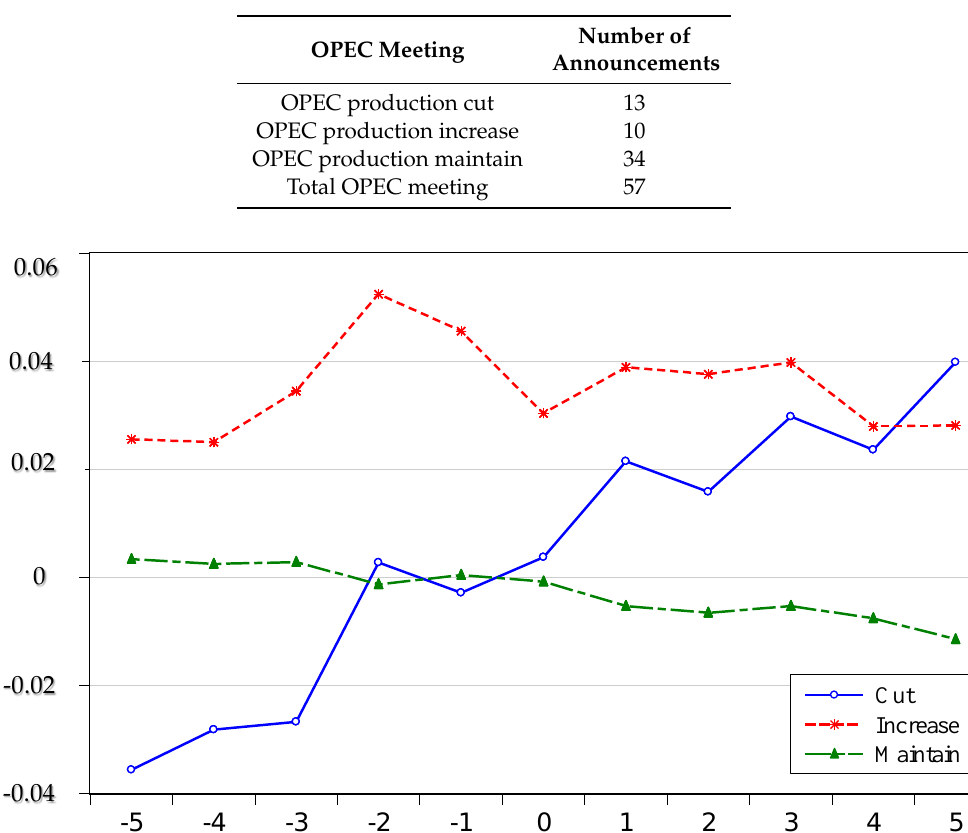
Figure 4. Average CARs of Brent spot price for OPEC’s announcements during two periods . Brent’s reaction 1 refers to the oil price reaction during pre-crisis periods, whereas Brent’s reaction 2 represents the price reaction during post-crisis periods.